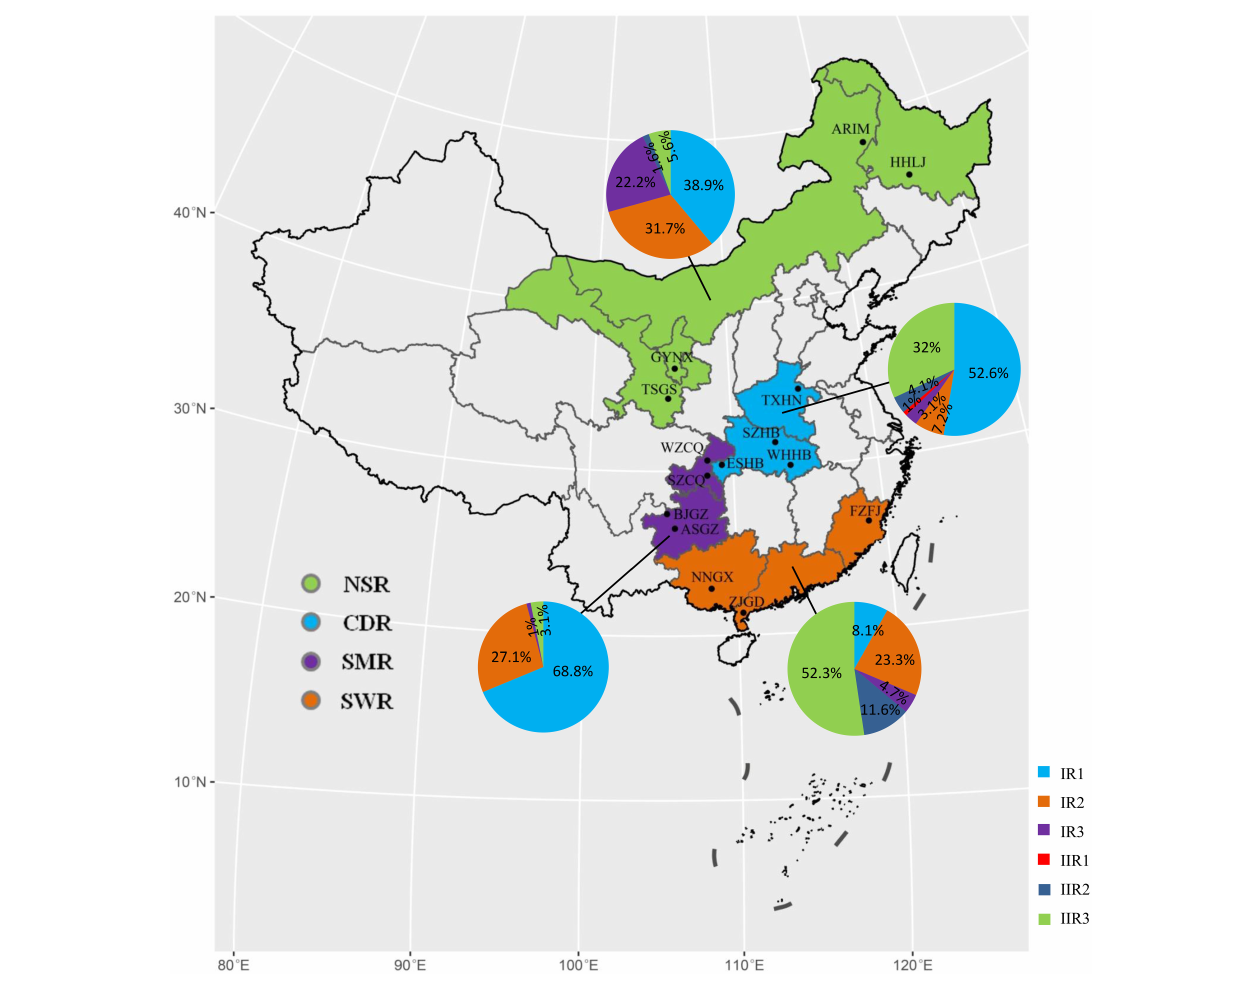
FIGURE 1 | Map showing the geographic origins and frequency distribution of mitochondrial haplotypes in the Phytophthora infestans populations sampled from four potato cultivation areas in China.